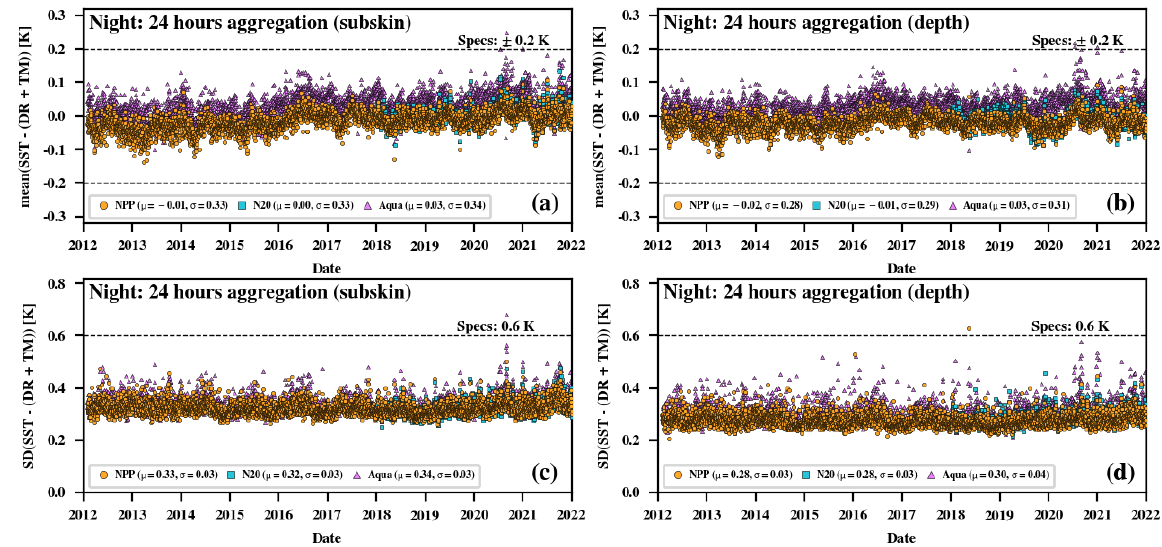
Figure 7. Times series of 24 h aggregated nighttime ACSPO-(D+TM) SSTs: ( a , b ) accuracy (global mean bias); ( c , d ) precision (corresponding SD); ( a , c ) ‘subskin’ SST (computed using global regression, GR); ( b , d ) ‘depth’ SST (computed using piecewise regression, PWR). Temporal means and SDs of the 24 h aggregated accuracy and precision are given by µ and σ , respectively. Data are from the NOAA SQUAM system [18].